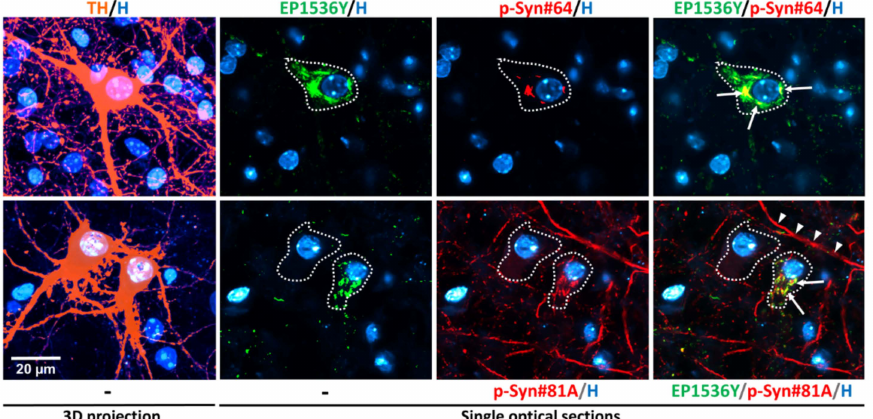
Figure 1. Comparative assessment of anti- α S (phospho-Ser129) antibodies for the detection of α Sa in midbrain cultured DA neurons. The confocal images above are from three-week midbrain cultures previously exposed two weeks before to 0.5 µ M F91. Upper panel: 3D projection of an individual TH + (orange pseudocolor for deep-red fluorescence) neuron and a single optical section from the same neuron, revealing the presence of a large somal α S inclusion identified with EP1536Y (green) and p-Syn#64 (red) antibodies. The merged image shows that EP1536Y detects a much larger portion of the inclusion than p-Syn#64. Lower panel: 3D projection of two DA neurons (orange) and single optical section showing a large somal α S inclusion in one of the two DA neurons using EP1536Y (green) and p-Syn#81A (red) antibodies. The green and red immunosignals are well superimposed in the soma of the DA neuron with the inclusion, but the red label is also seen in elongated cellular elements that obviously do not contain aggregates. Nuclear counterstaining was performed with Hoechst-33342 (H; blue). White arrows depict coincident p- α S immunosignals (yellow) whereas white arrowheads point to non-specifically labelled